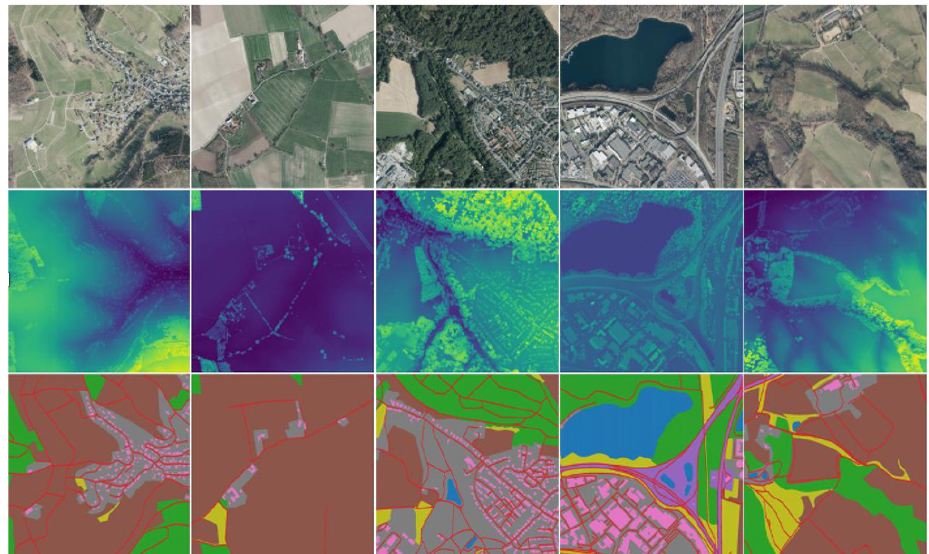
Figure 10. GeoNRW Dataset. We randomly sampled six data pairs in the dataset, in which each column represents a set of data. The first row represents RGB imagery, and the second row represents DSM imagery. The third row represents the Semantic Segmentation